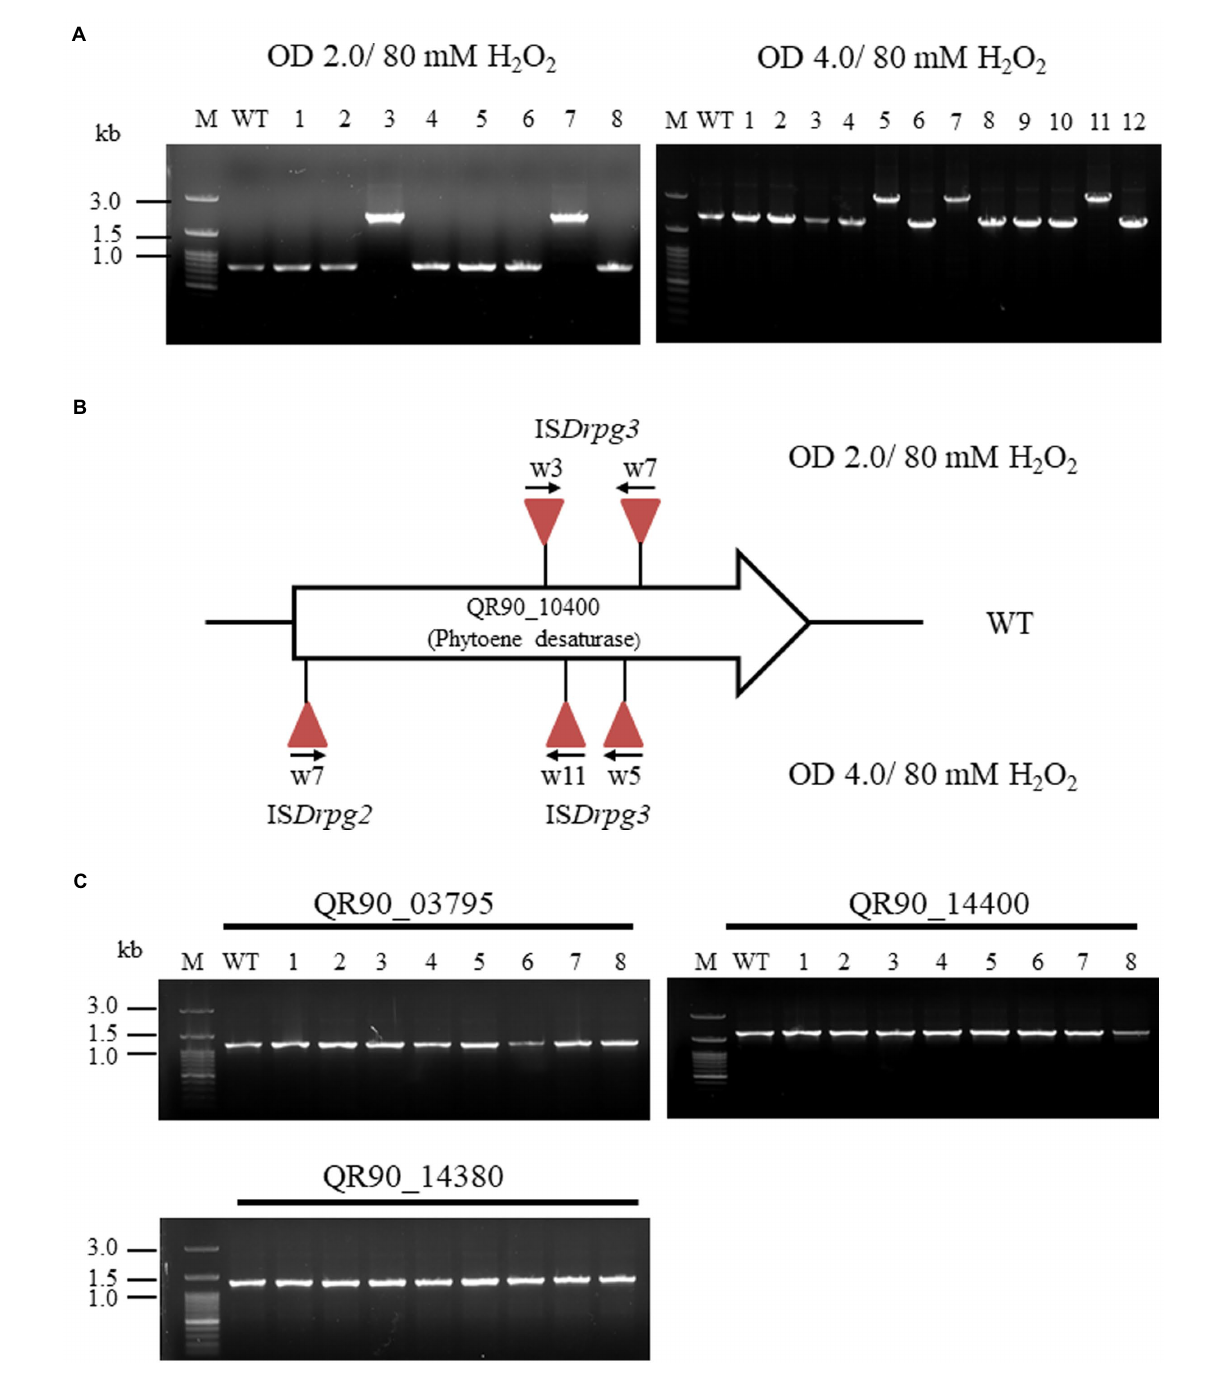
FIGURE 5 Insertion sequence transposition triggering at low concentration of H 2 O 2 treatment with 80 mM. (A) , Detection of IS transposition at two growth phases (OD 600 2.0 and 4.0) in gene QR90_10400. (B) , Analysis of IS integrational loci at both detection conditions. All transposed IS elements are both IS Drpg2 and IS Drpg3 of the IS 4 family members. (C) , Analysis of IS transposition in three carotenoid biosynthesis-related genes. These genes were not affected by IS integration under H 2 O 2 oxidative stress